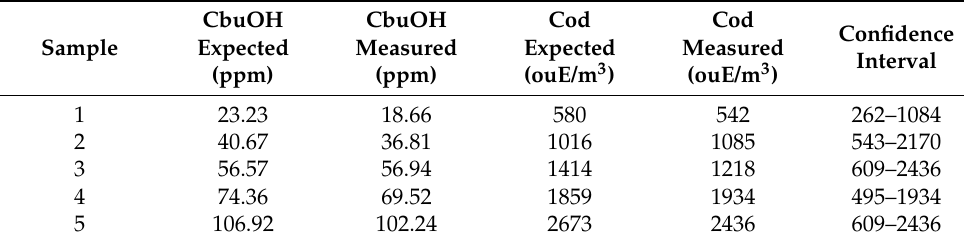
Table 2. Chemical and olfactometry results.